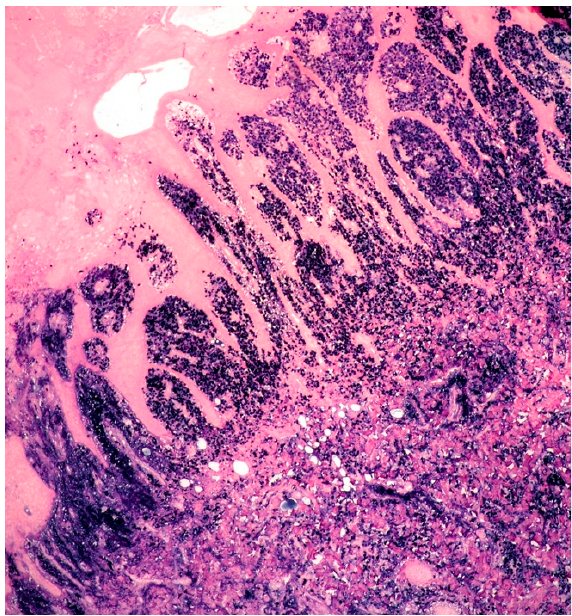
Figure 12. Cutaneous localization of PBL: diffuse EBV positivity, typically found in PBL and documented by EBER (in situ hybridization, magnification 40×; original image from Prof. S.A.).